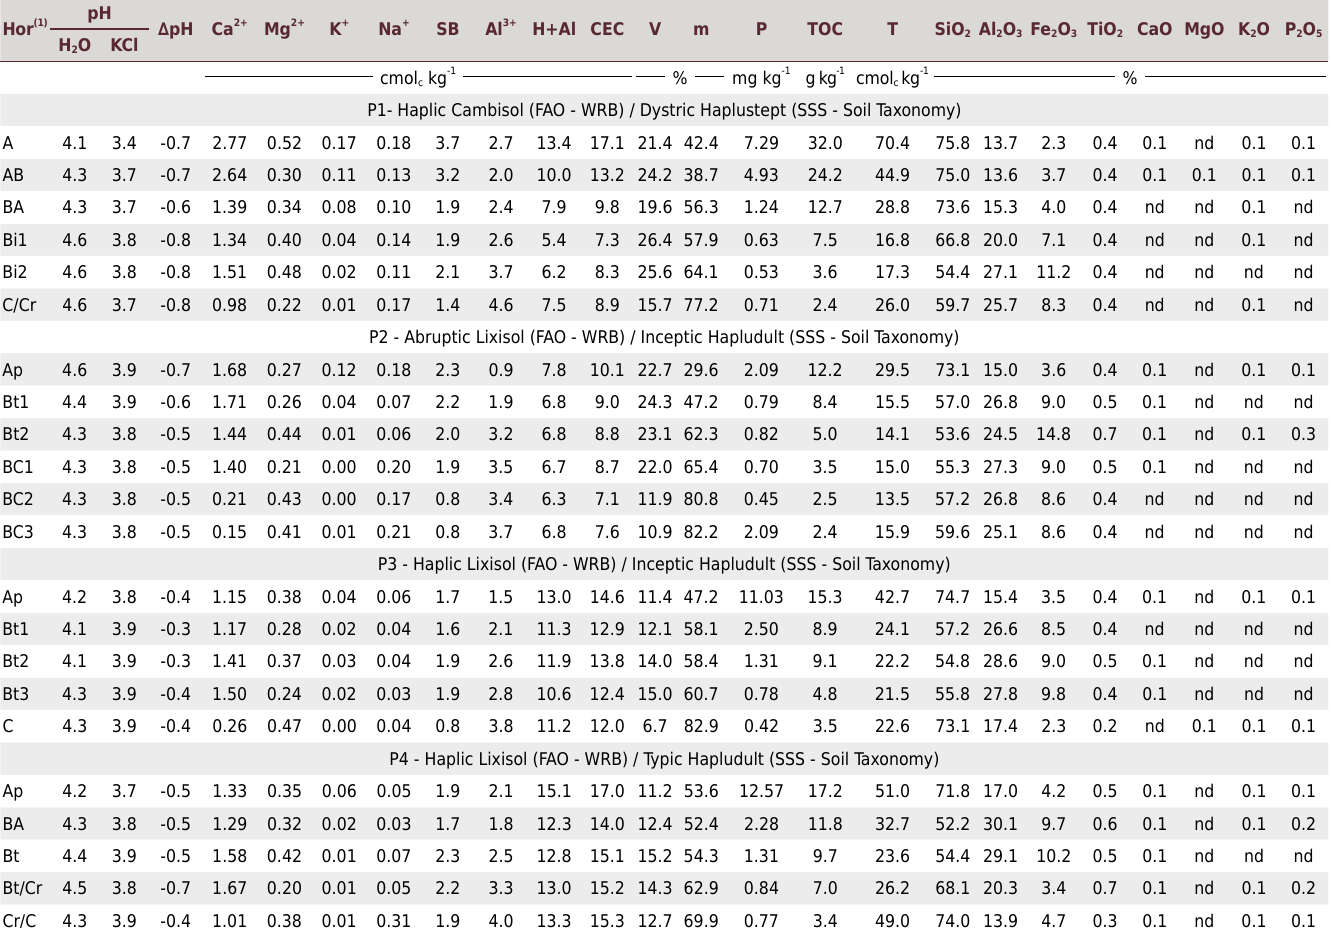
Table 2. Chemical properties of soils in a rhyolite toposequence in the Ipojuca formation, Sirinhaém, PE, Brazil pH Hor (1) ∆pH Ca 2+ Mg 2+ K